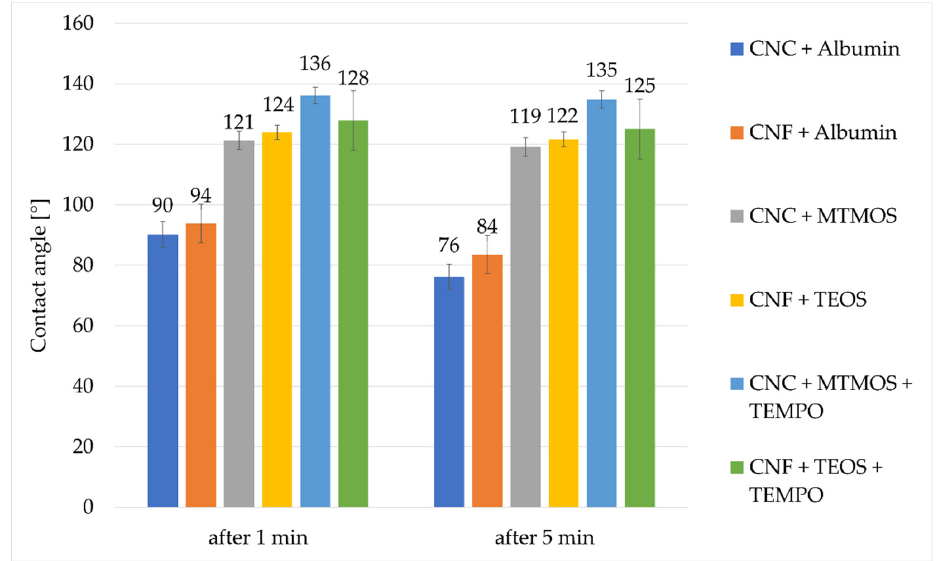
Figure 7. Water contact angle (WCA) of samples 1 and 5 min after drop application. Table 1. Statistical parameters of the water contact angle (°) of samples.